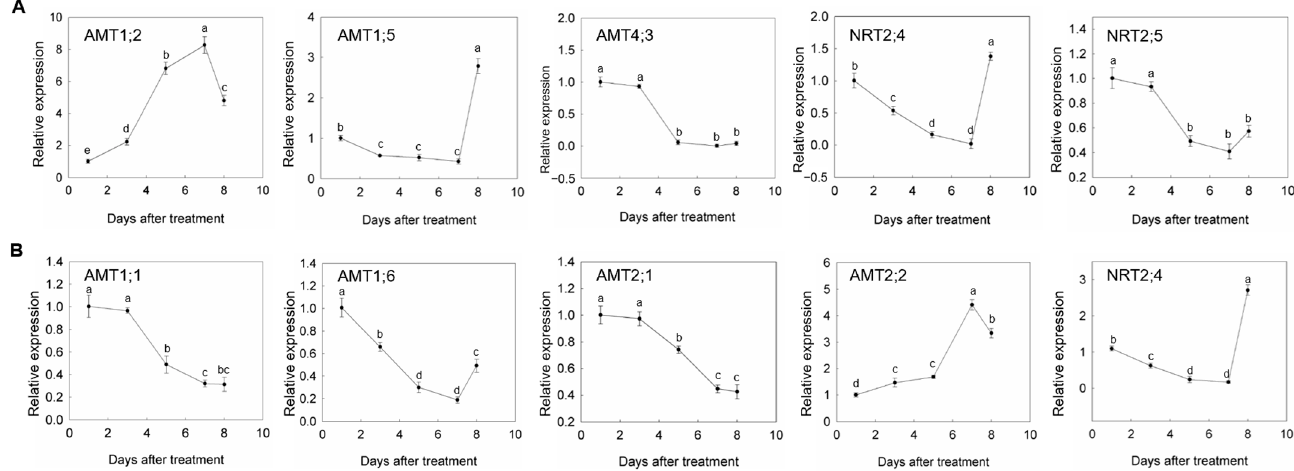
Figure 4. The effect of drought and rewatering on expression levels of key AMTs and NRTs in Figure 4. The e ff ect of drought and rewatering on expression levels of key AMTs and NRTs in roots roots ( A ) and leaves ( B ) of Malus hupehensis plants. Bars labelled with different letters indicate ( A ) and leaves ( B ) of Malus hupehensis plants. Bars labelled with di ff erent le tt ers indicate signi fi cant significant di ff erence.